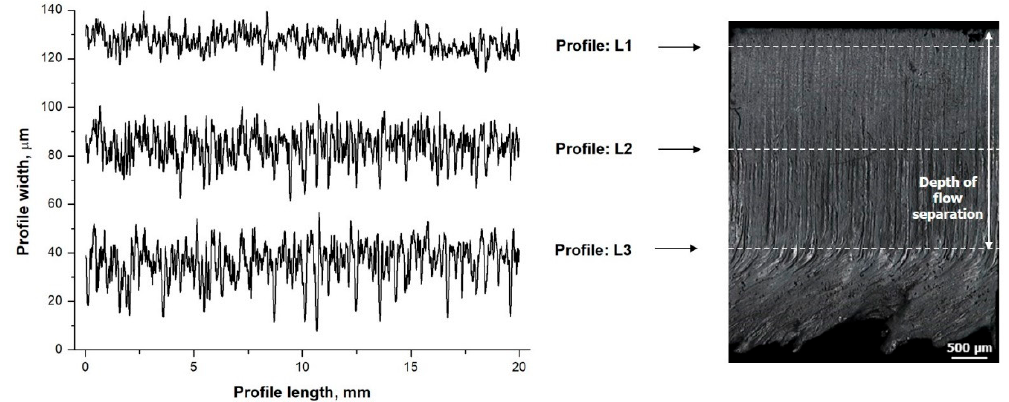
Figure 24. Depth of flow separation in 6 mm thick AlMg3 cut with Cs = 100% and P = 50%.